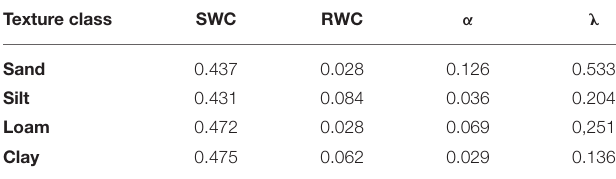
TABLE 5 | Estimates for saturated water content (SWC), relative water content (RWC), air entry pressure of the soil ( α ), and unimodal soil pore size distribution ( λ ) from pedo-transfer functions of Rawls and Brakensiek (1989) used in TDEF.